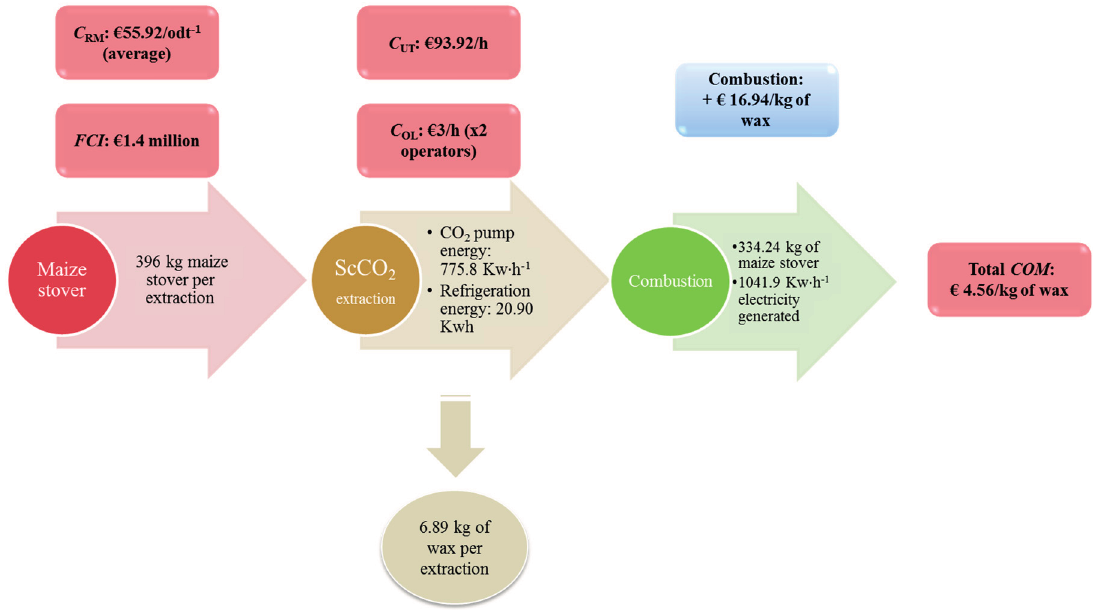
Figure 3. Schematic highlighting the energy and material inputs for maize leaf